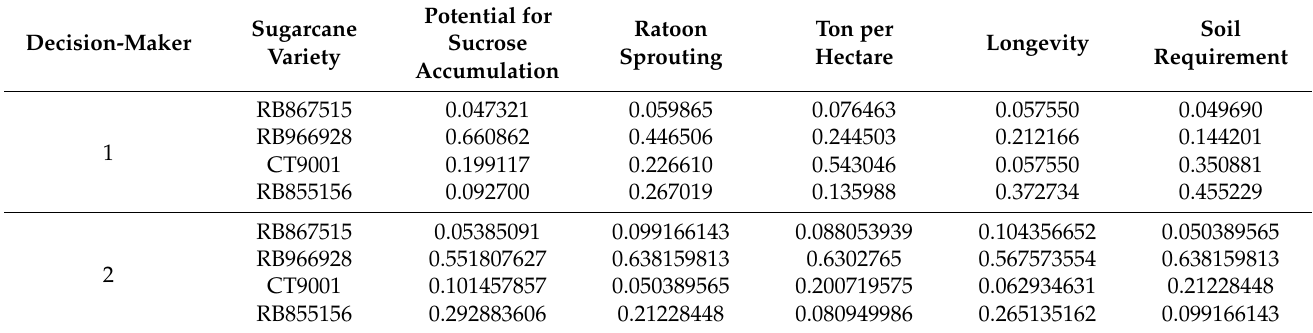
Table 3. Preference matrix of each variable and sugarcane variety for both decision-makers.